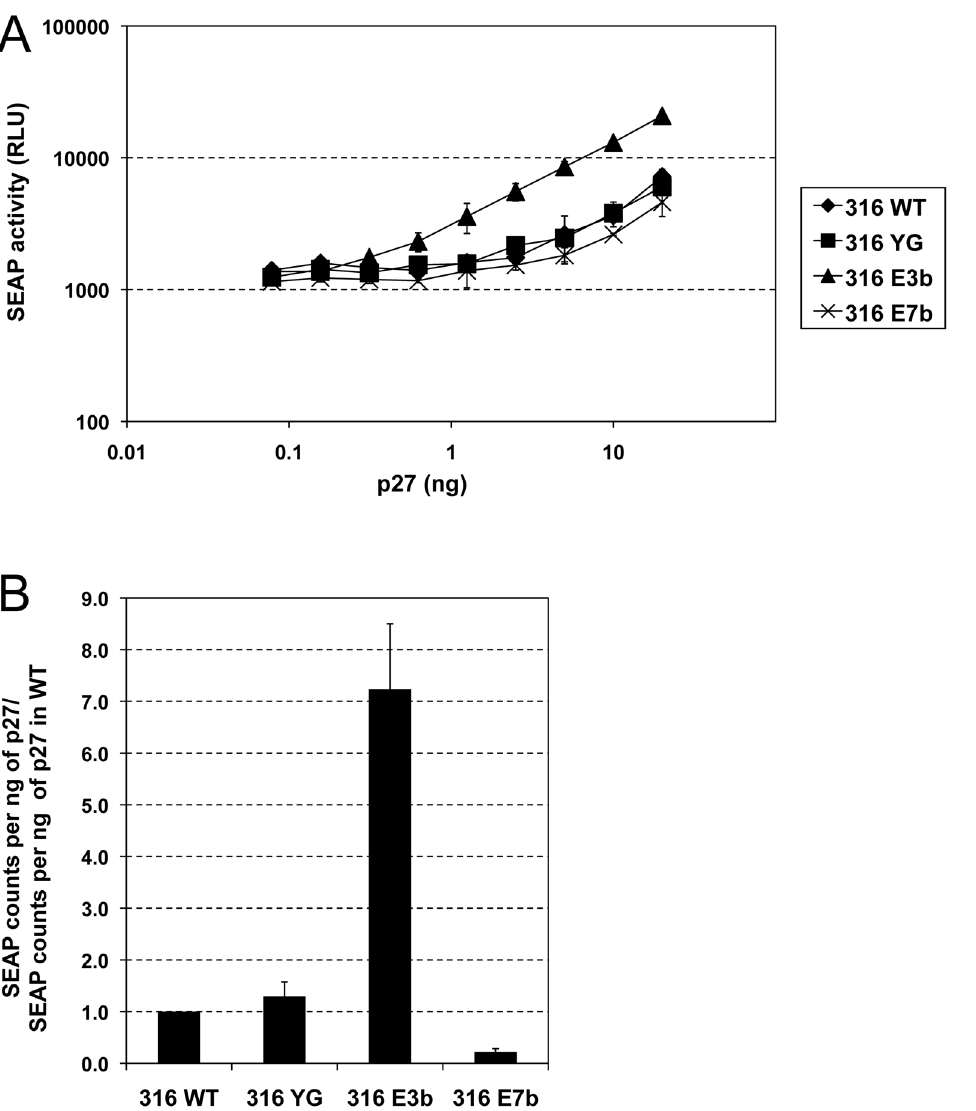
Figure 8. Viral infectivity of SIVmac316 is increased when multiple potential trafficking motifs in gp41CD are eliminated. Viruses were produced by transfection of HEK293Tcells and virions were pelleted from the clarified supernatants. Stocks were normalized for p27 content and used to infect C8166-45 SIV-SEAP cells with serial dilutions. ( A ) SEAP activity 3 days after infection. Error bars indicate standard deviation of triplicates. ( B ) SEAP activity per ng of p27 input, normalized for wild-type virus. Average of 2-3 independent experiments, error bars indicate standard deviation. WT, wild-type. SEAP, secreted alkaline